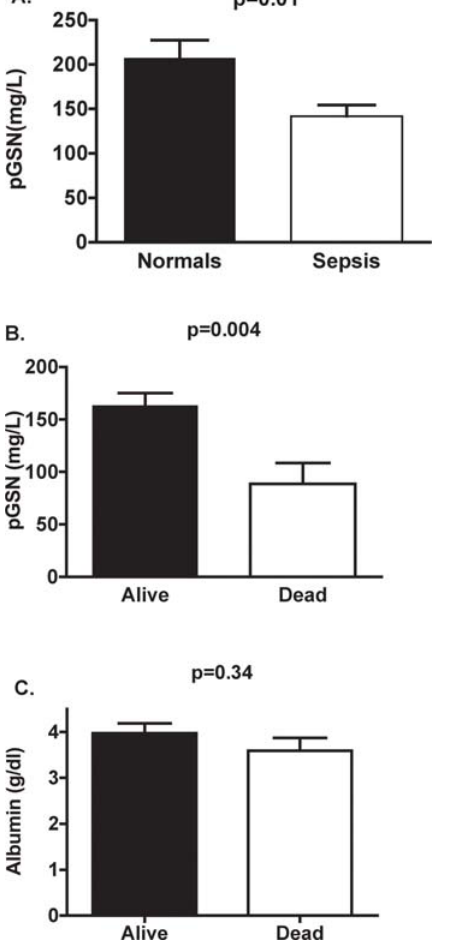
Figure 2. Degree of pGSN depletion is associated with sepsis mortality. A. Septic patients had lower pGSN levels compared to normal controls (p=0.01). B. Septic patients who survived at 28 day of admission had significantly higher pGSN levels than those who did not survive (p=0.004). C. Albumin levels did not differ between survivors and non-survivors.